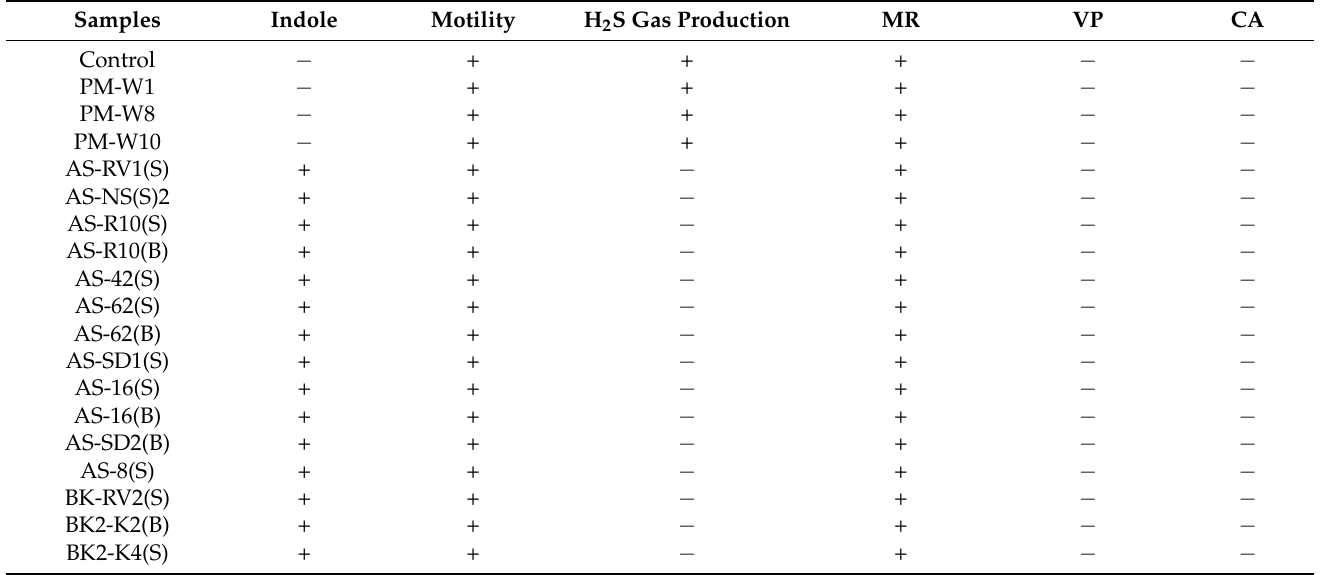
Table 2. IMViC test result of presumptive E. coli isolated from 3 aquaculture farms and 6 Sarawak rivers in the northwest of